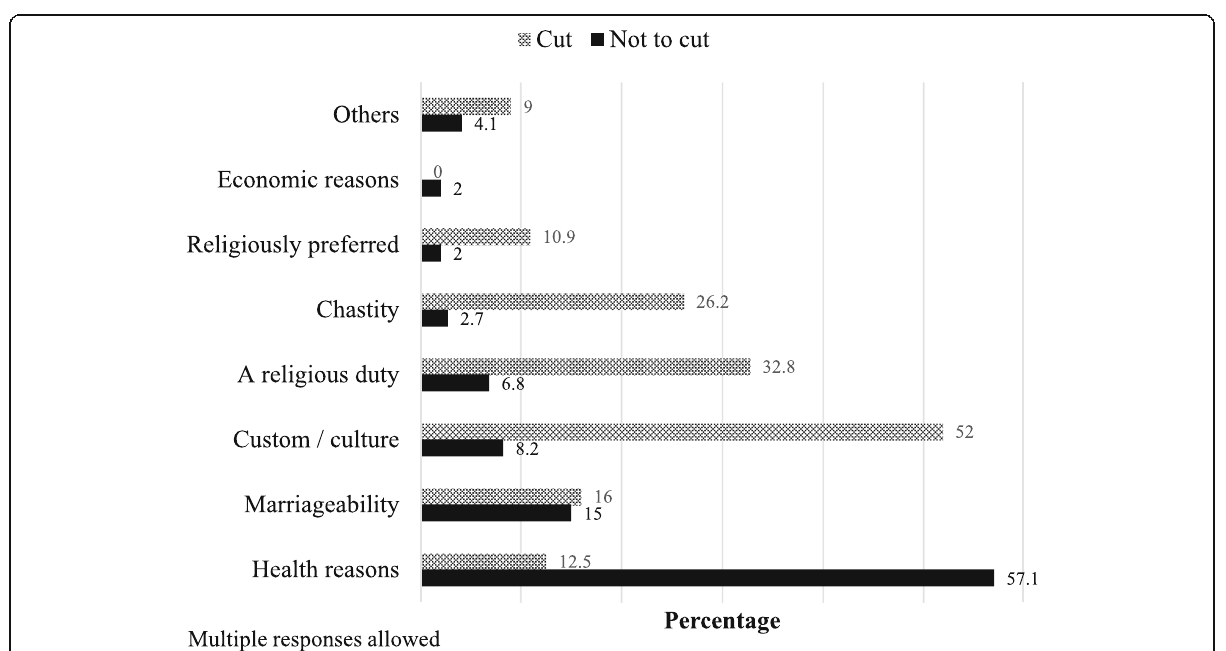
Fig. 2 Reasons for final household decision to either cut the youngest daughter or leave her